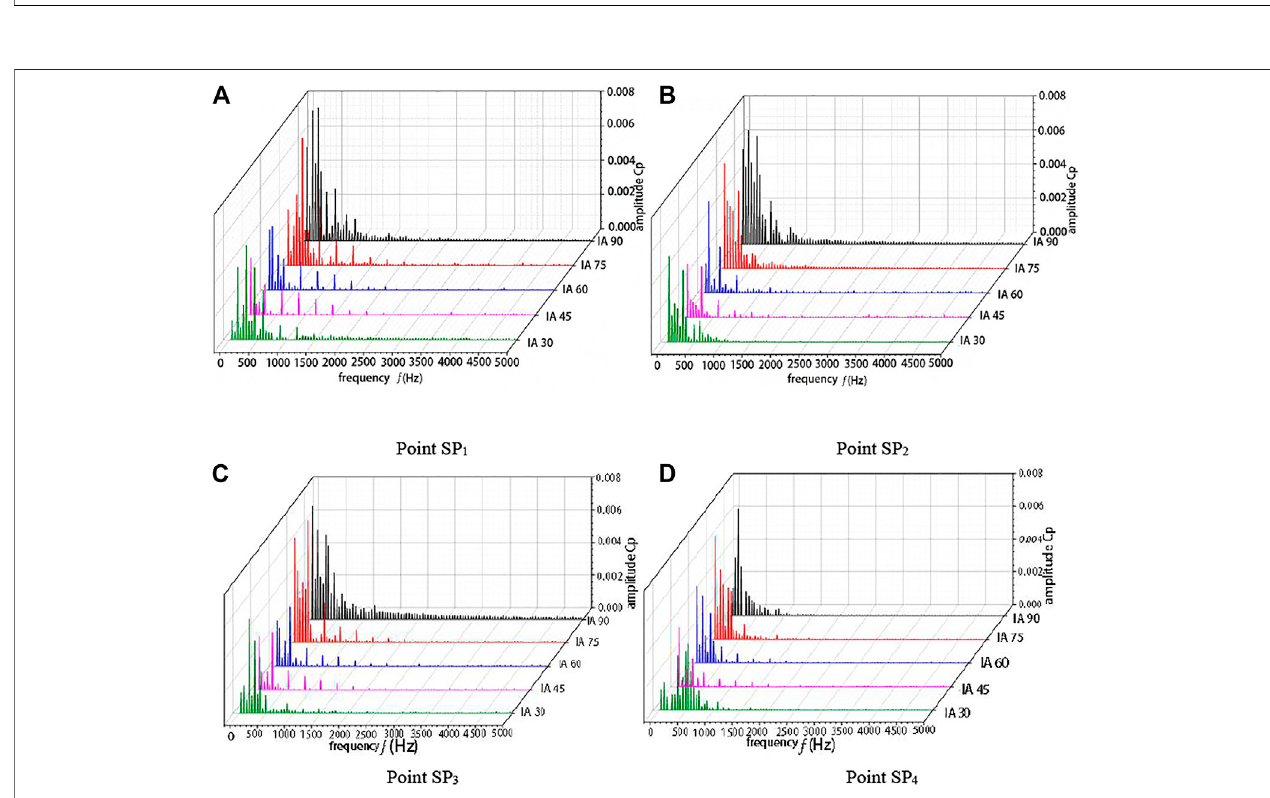
FIGURE10| Comparisonofshaftfrequencyandbladefrequencyofpressurepulsationinwear-ringclearanceunderdesignconditionsanddifferentincidentangles of wear-ring clearance. (A) Point SP 1 . (B) Point SP 2 . (C) Point SP 3 . (D) Point SP 4 .